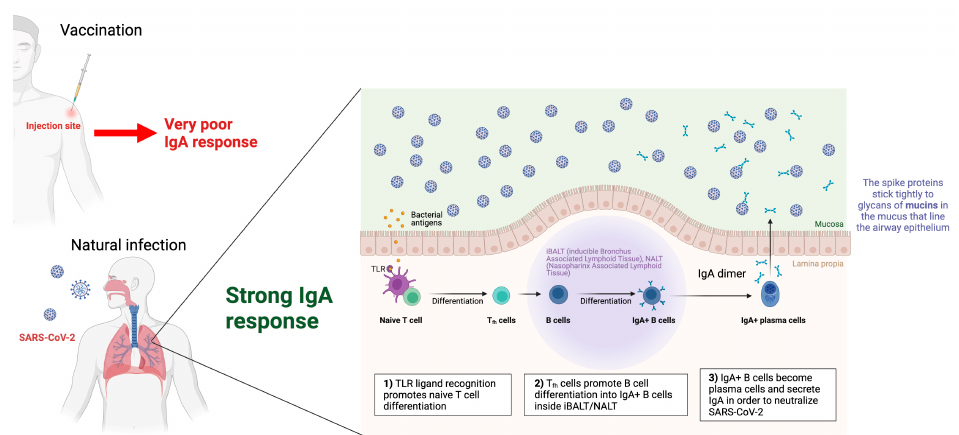
Figure 1. Natural infection leads to greater production of lgA compared to vaccination. IgA is produced in the mucous membranes through the activation and maturation of B lymphocytes and consequently of plasma cells in subjects naturally infected by SARS-CoV-2. On the other hand, vaccination only minimally elicits the IgA production in the mucous